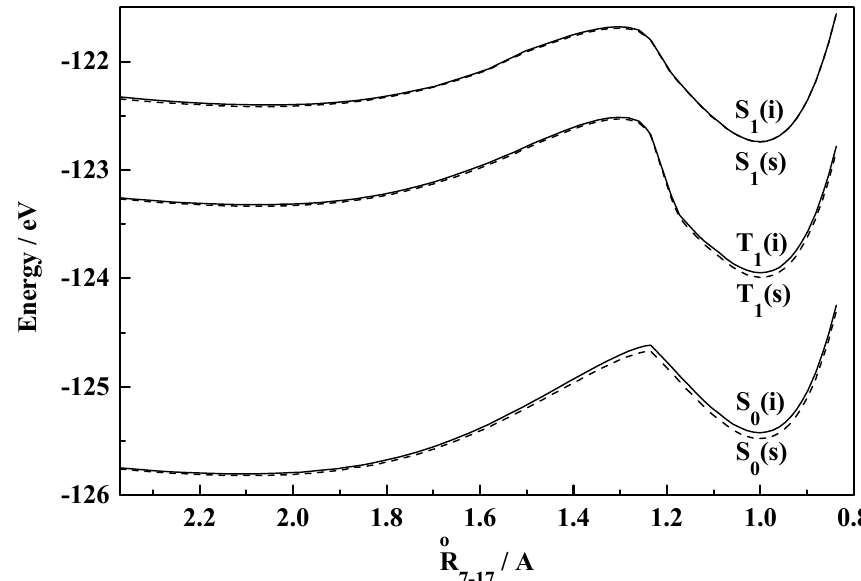
Figure 9. Simulated PECs for IPT process of HBT in S ethanol).